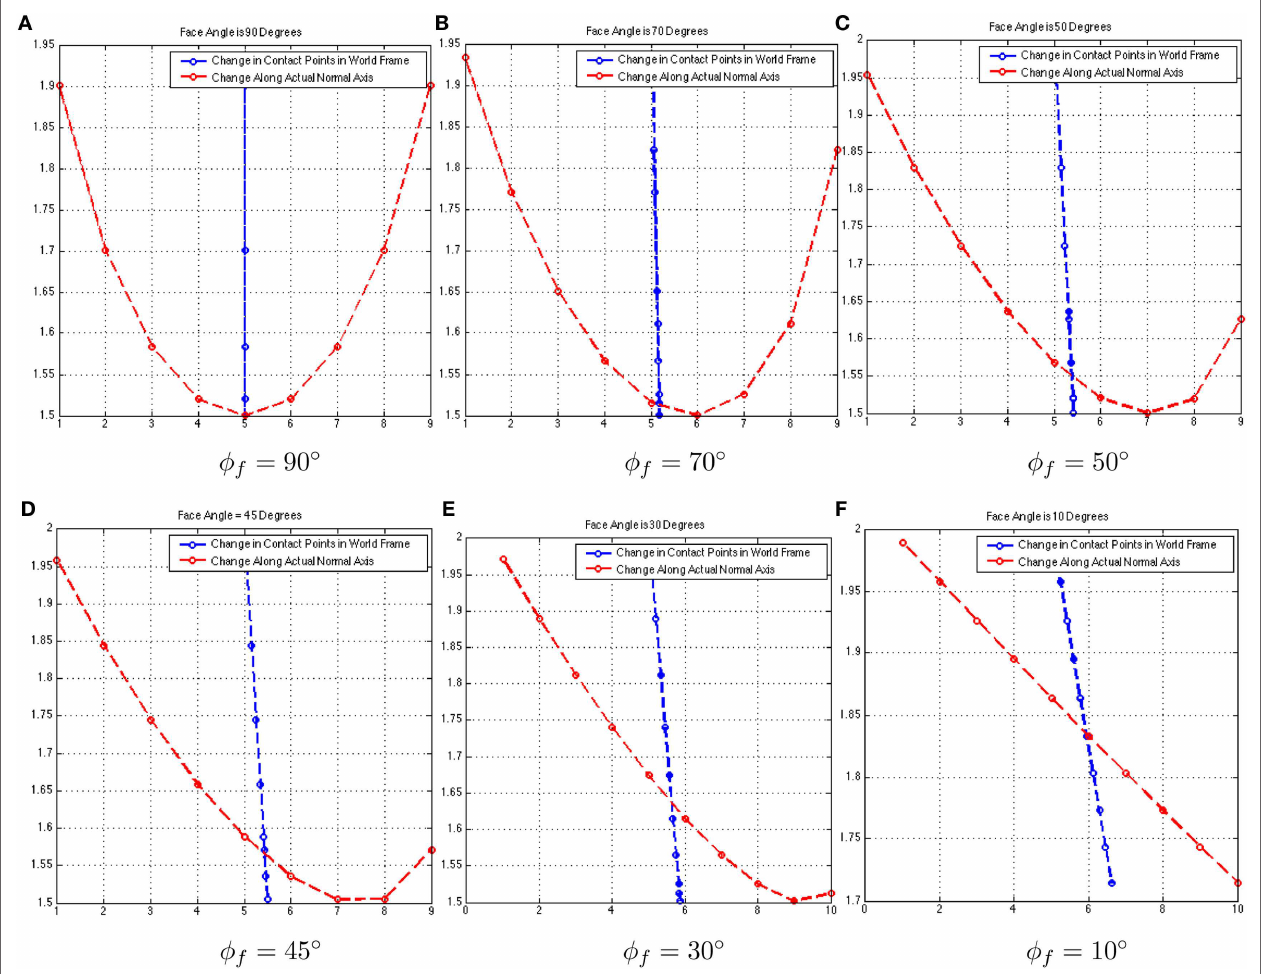
FIGURE 11 | From (A–F), the curves in red shown c y = c x tan( ϕ f ) and the lines in blue show ( δ c y , δ c x )